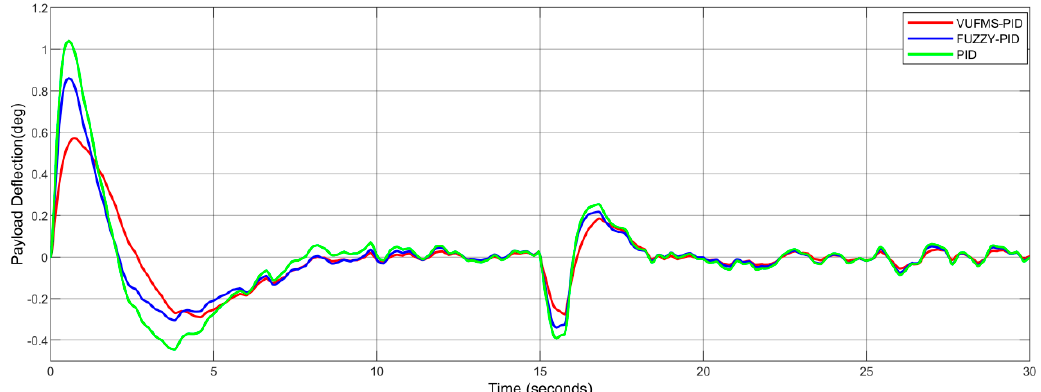
Figure 21. Trolley’s position using VUFMS-PID, FUZZY-PID and PID controller under working condition 4 with a crosswind and white noise.